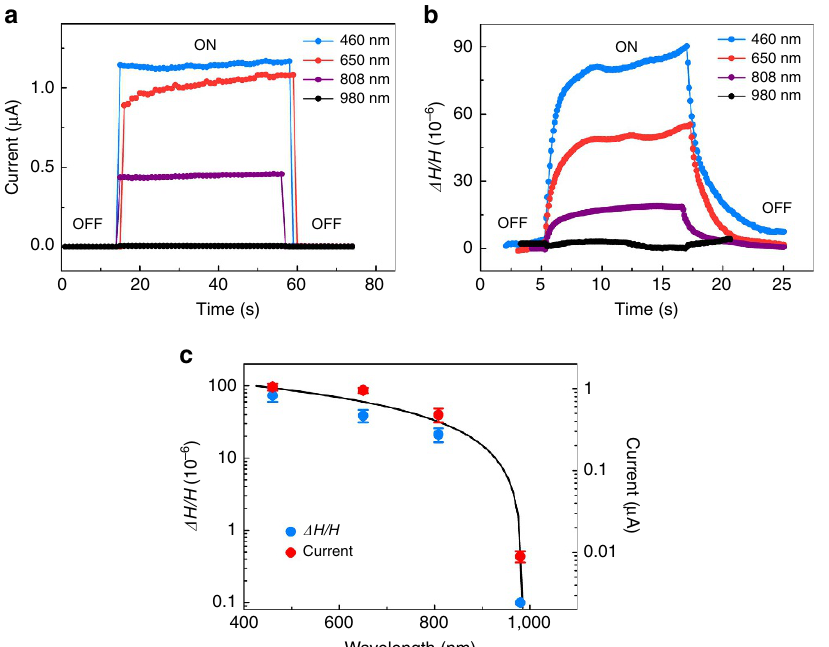
Figure 3 | Photon energy dependence of the photostriction. ( a ) When the photon energy is close to or above the band gap (that is, 460, 650 and 808nm lasers), large current on illumination (under 1V voltage) is observed, whereas negligible photocurrent is obtained when photon energy is below the band gap (that is, 980nm laser). ( b ) The photostriction shows similar behaviour to that of photocurrent. ( c ) Photocurrents and height changes of the single crystal as functions of the incident photon energy, showing clear correlation between these two properties. The light intensity was kept at B 100mWcm (cid:3) 2 for all lasers. The black solid line serves as a guide to the